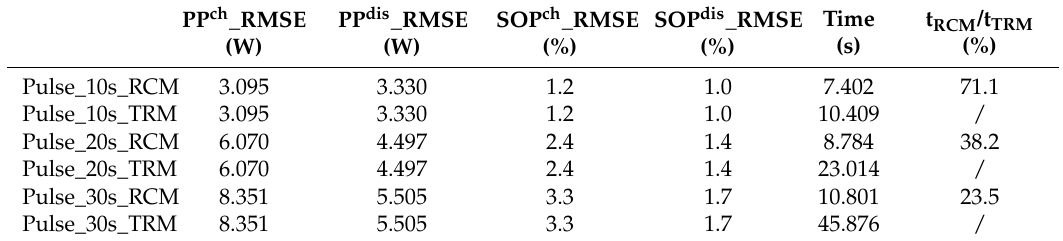
Table 2. The comparison between the rapid-calculating method (RCM) and the traditional method